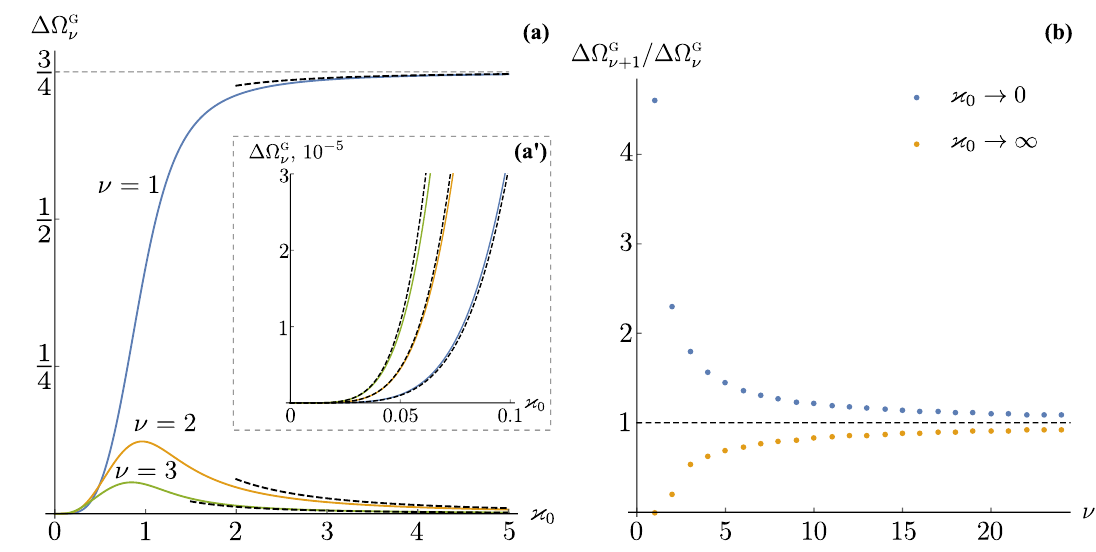
Figure 4: Widths of the band gaps: (a) Exact values of the first three band gaps (solid lines) are compared to the analytical asymptotes listed in Table 1 (dashed line). The inset (a (cid:48) ) shows vicinity of the origin. (b) Ratio of widths of two neighbouring band gaps for opposite limit cases of the vanishing and infinite